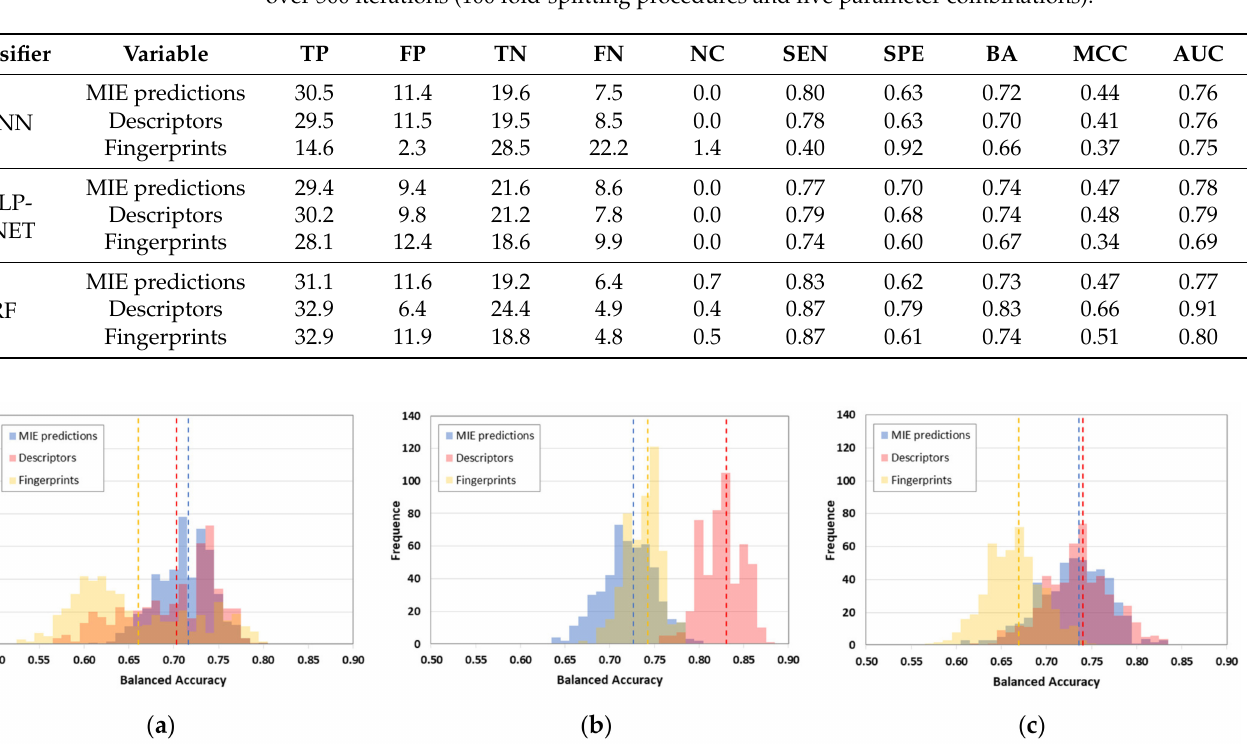
Table 2. Performance of the three classifiers (kNN, RF, NNET) using MIE predictions, chemical descriptors, and extended fingerprints as independent variables. For each method, the average